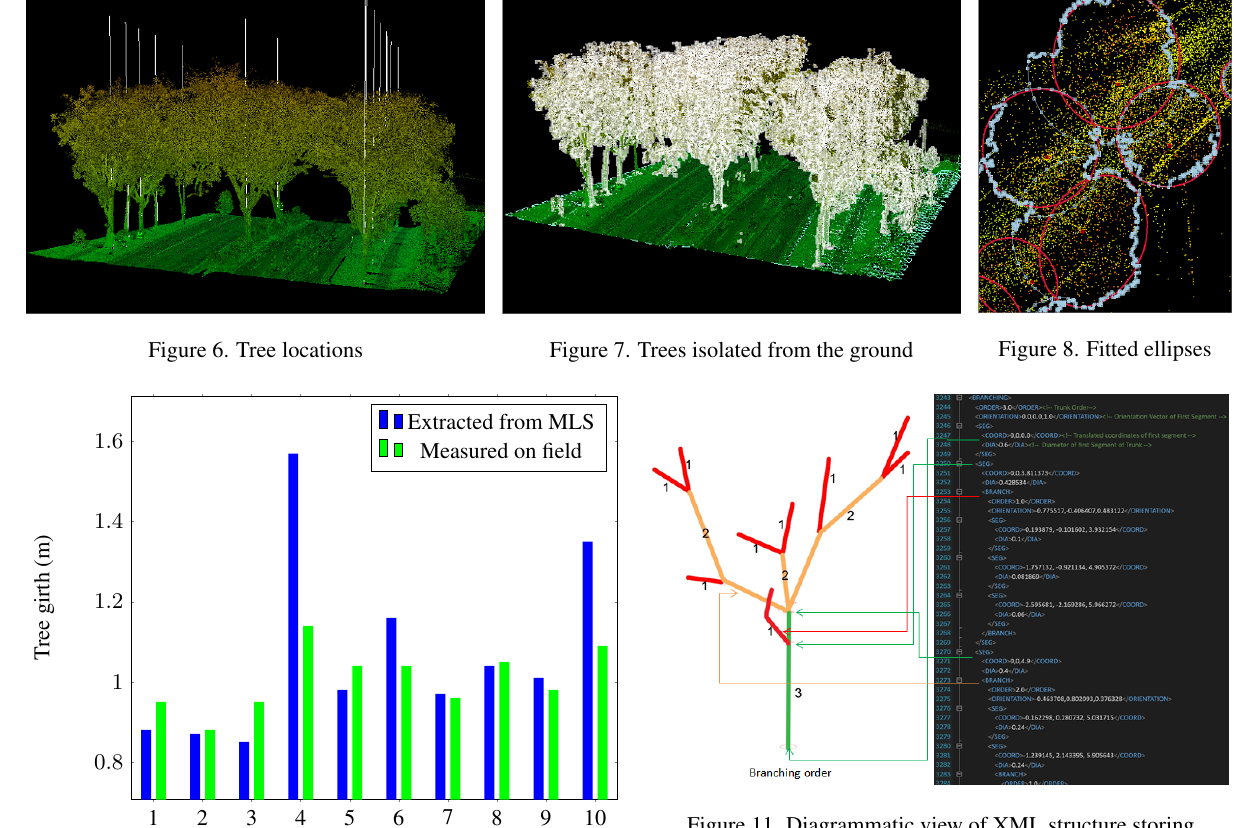
Figure 9. Girth comparison between MLS-extracted measurement and on-field measurement